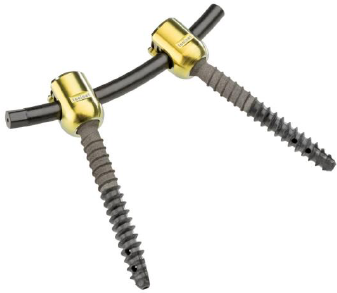
Figure 1. Non-metallic X-ray-translucent carbon fiber reinforced polyetheretherketone (CF/PEEK) pedicle screws (icotec: VADER®, Altstätten, Switzerland).